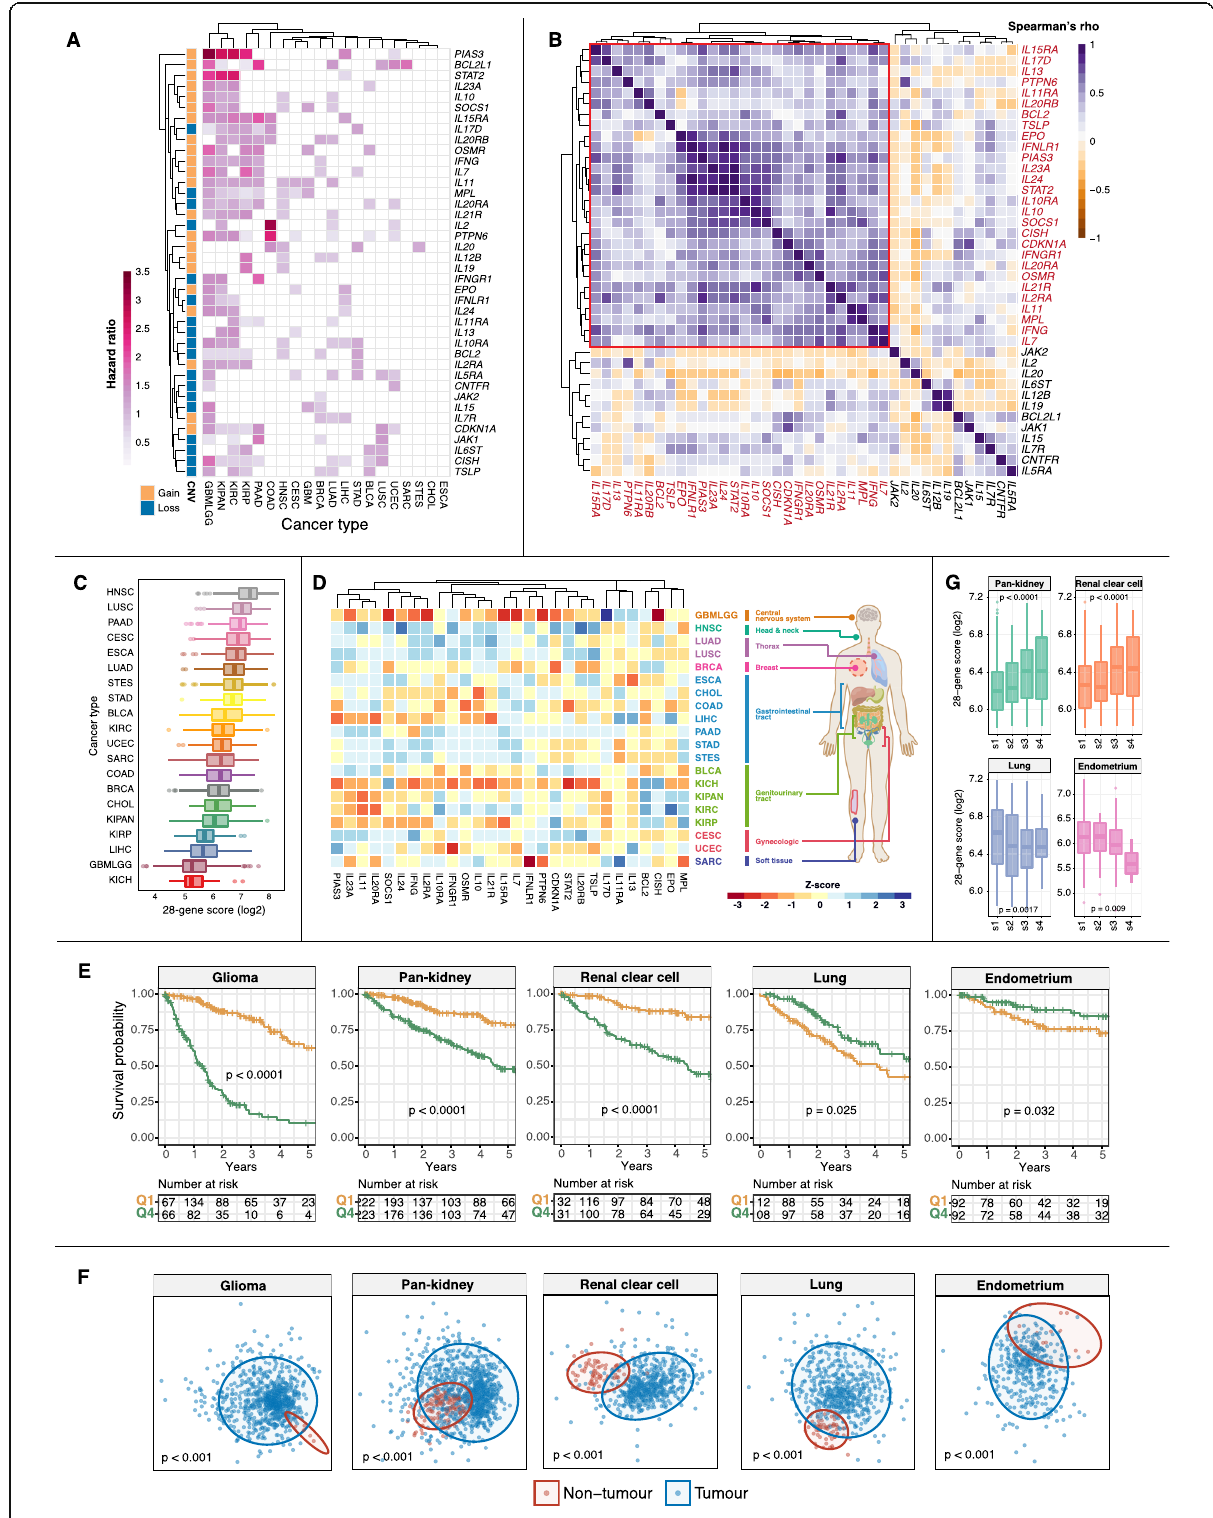
Fig. 2 (See legend on next